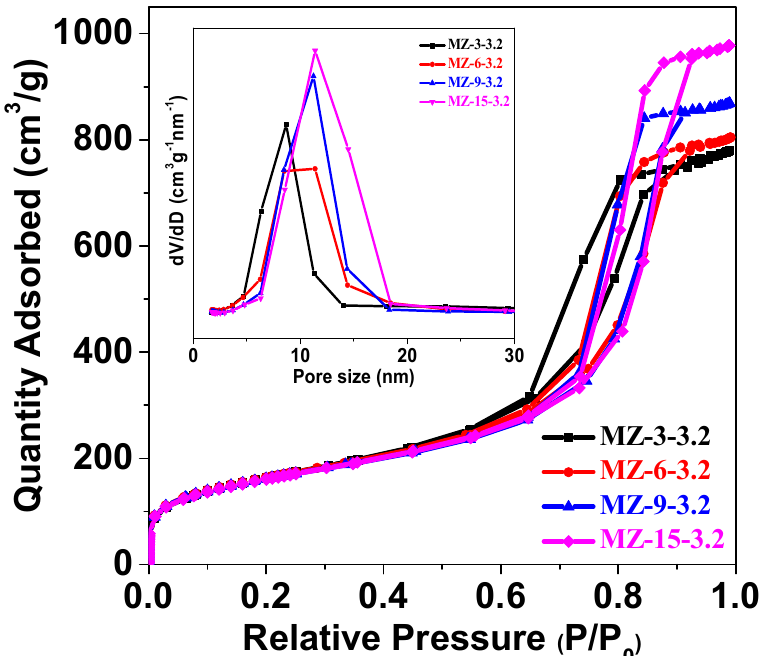
Figure 4. N 2 adsorption–desorption isotherms of and the BJH pore size distribution of MZ-3-3.2, MZ-6-3.2, MZ-9-3.2, and MZ-15-3.2.